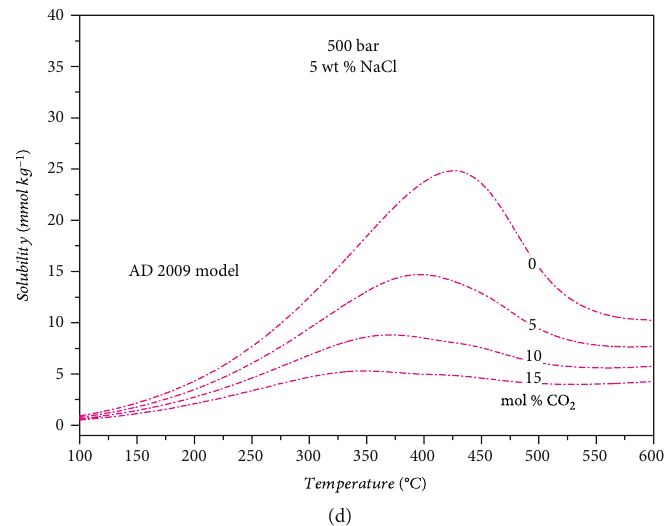
Figure 7: Comparisons of model predictions in H CO compositions from 0 to 15mol 2